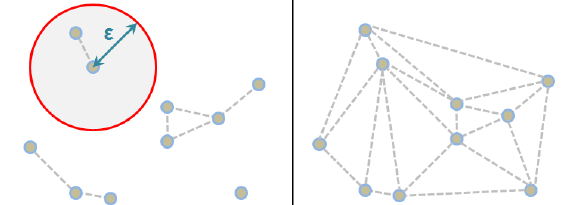
Figure 2. Spatial point processes. Spatial interactions between points (see dashed grey lines) in standard point processes are typically defined via a tolerance distance (cid:15) (left). Instead, Delaunay point processes (right) define interactions through Delaunay edges in a parameter-free